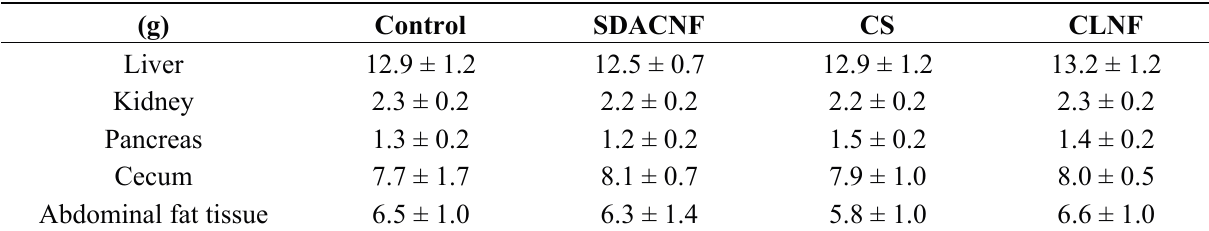
Table 2. Effects of oral administration of SDACNFs on organ weights. The table indicates the results of liver, kidney, pancreas, cecum, and abdominal fat tissue. Data are presented as mean ± standard